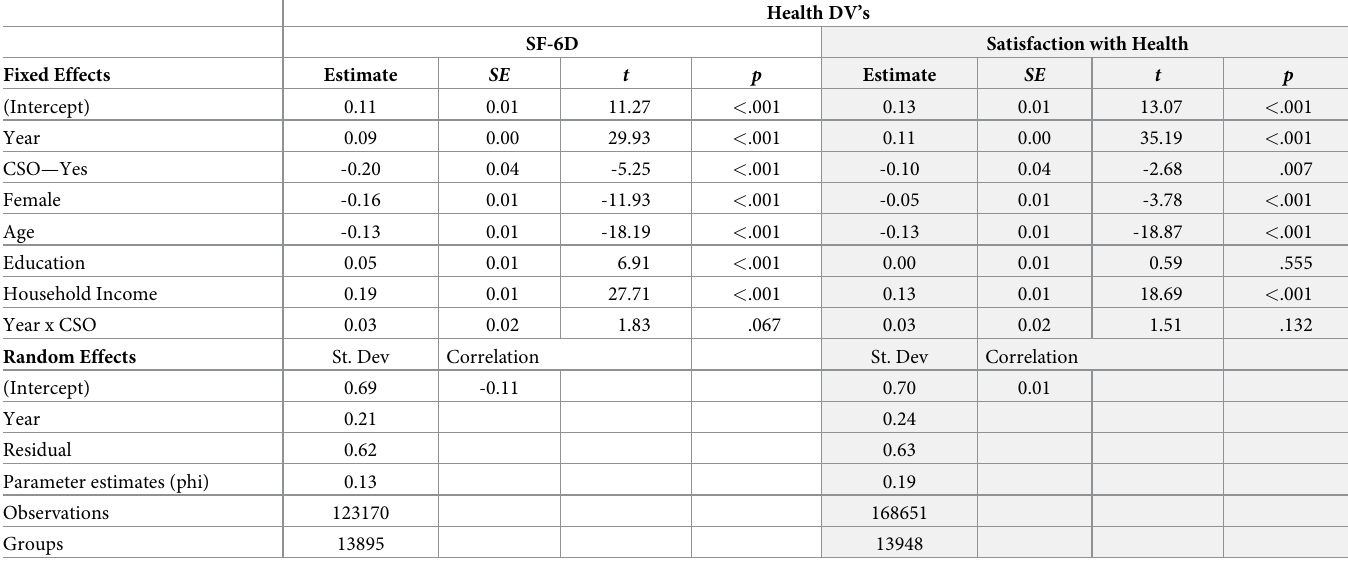
Table 4. Generalised linear mixed-effects model results for health variables.